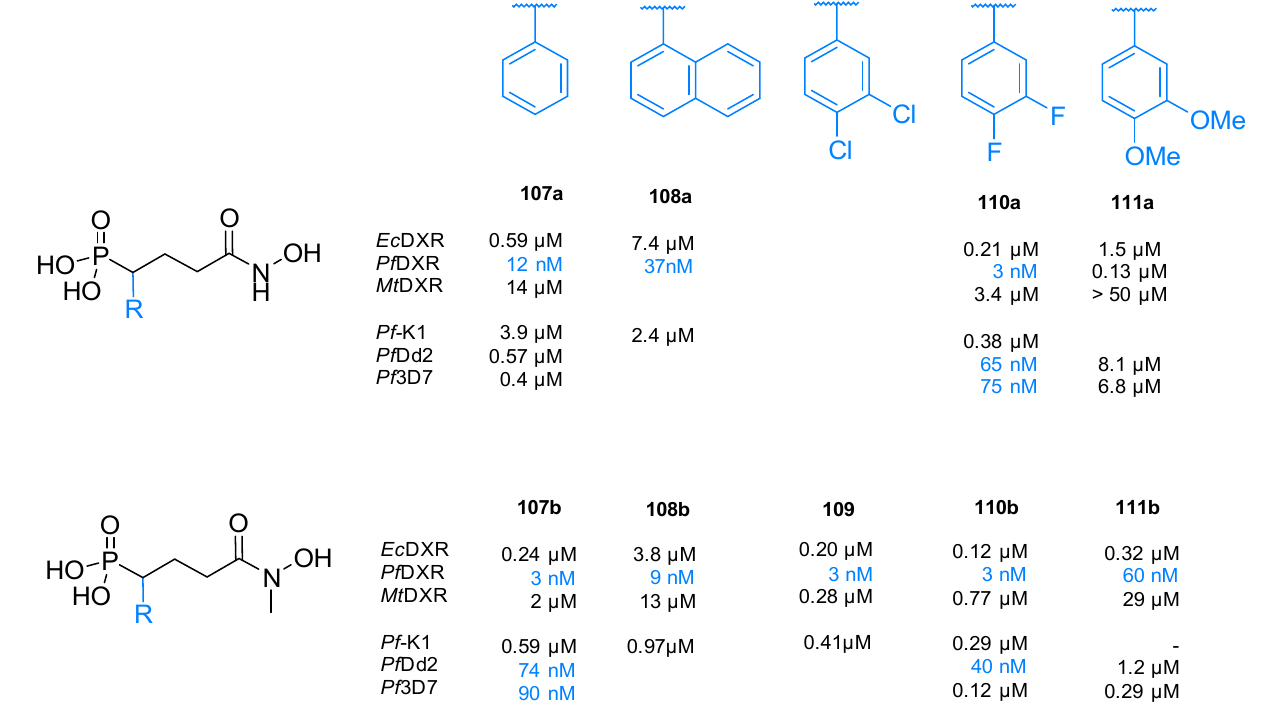
Figure 25. Schematic overview between 110b (green) and the active site of Ec DXR. Intramolecular van der Waals interactions (light blue) between the N -methyl group with the difluorophenyl ring and the linker atoms of 110b . Distances are in Å [100] . Reprinted with permission from J. Med. Chem. 2011, 54, 6796–6802 [100]. Copyright 2022 American Chemical Society. 4.3.5. Reverse α -Substituted Oxa, Thia and Aza Analogs Based on the promising α -phenyl-substituted reverse carba analogs, Kurz and coworkers developed bioisosteric α -substituted β -thia and β -oxa analogs ( 112 – 115 , Figure 26) [93,138,142,143]. Compounds 112 – 115 were tested against Pf, Mt and Ec DXR enzymes as well as in antiplasmodial growth assays towards Pf Dd2 and Pf 3D7. The β -oxa analogs with an unsubstituted hydroxamic acid group ( 113 ) were at least 2 orders of magnitude less potent than their N -methylated analogs 112a – h in all DXR enzymes and Pf growth